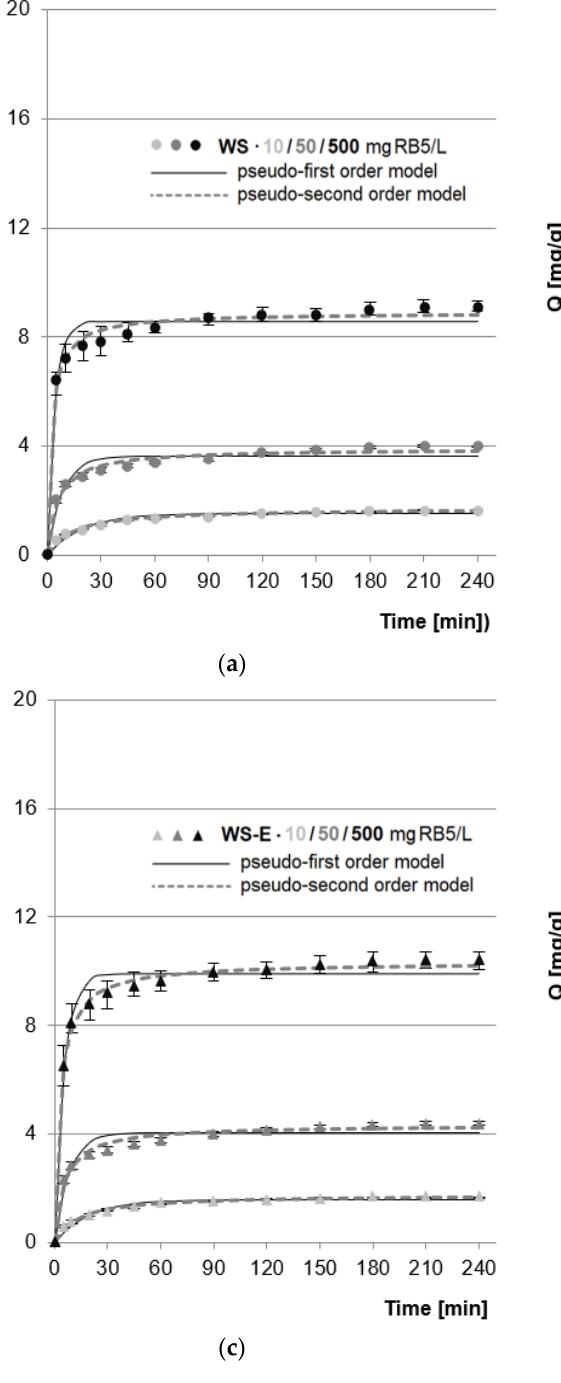
Figure 4. Changes in RB5 concentration during sorption onto: ( a ) WS; ( b ) WS-A; ( c ) WS-E; and ( d ) WS-EA, (average + range). Conc. of the solution: 50–500 mg RB5/L, dose of the sorbent: 5 g/L, mixing speed: 150 r.p.m., sorption time: 0–240 min, temp. 22 °C.